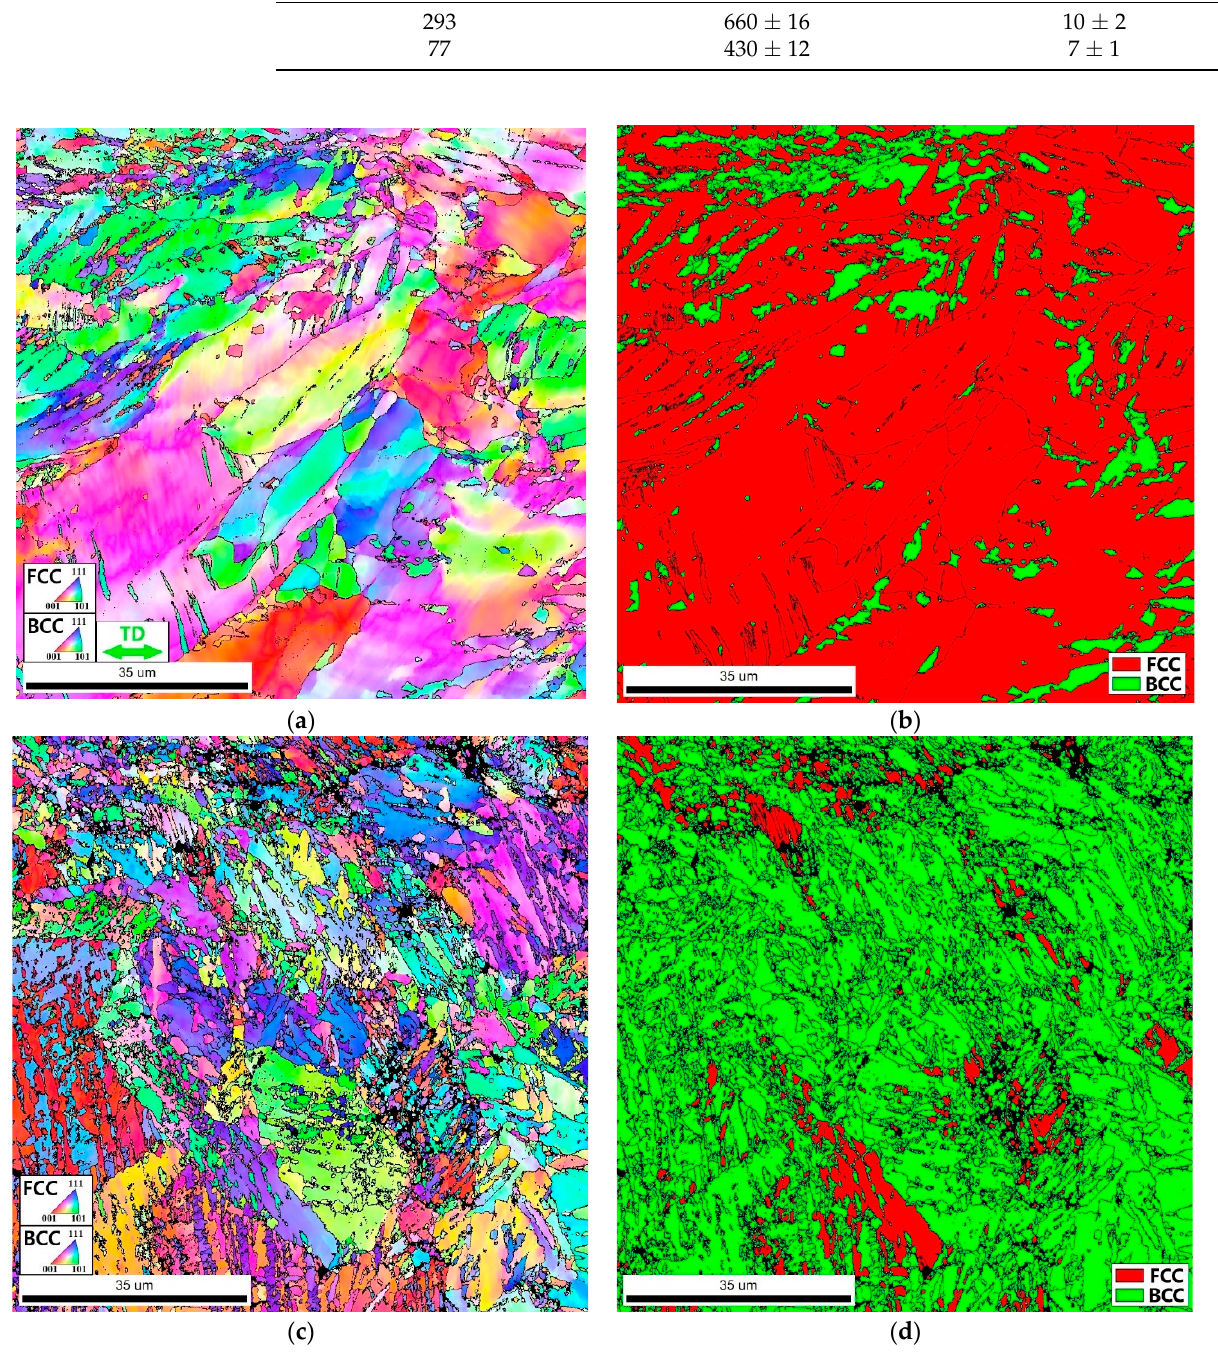
Figure 10. IPF ( a , c ) and phase ( b , d ) maps of the as-produced (mode: P = 200 W and V = 1600 mm/s) Fe 65 (CoNi) 25 Cr 9.5 C 0.5 alloy after tension to fracture at room ( a , b ) and cryogenic ( c , d ) temperatures. The tension axis was horizontal in all cases.